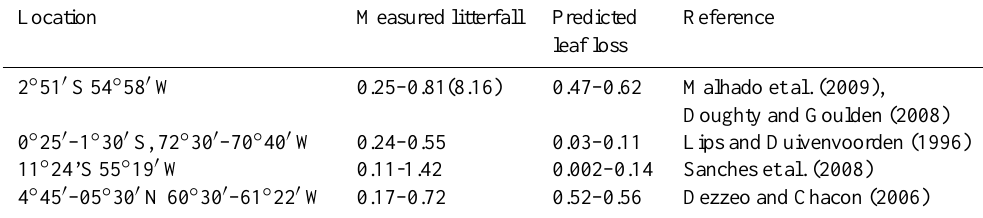
Table A1. Comparison of leaf litterfall as predicted by the model and ground-based measurements across the Amazon